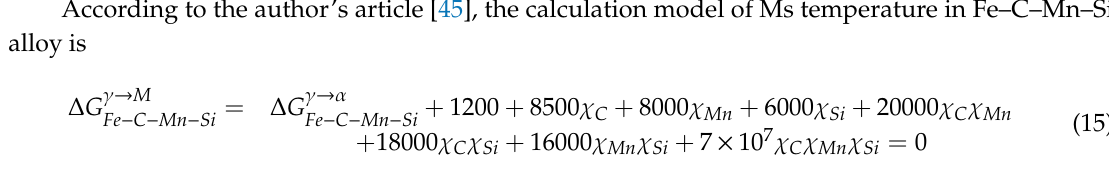
Figure 7. TRIP steel: Internal friction-temperature spectrum.